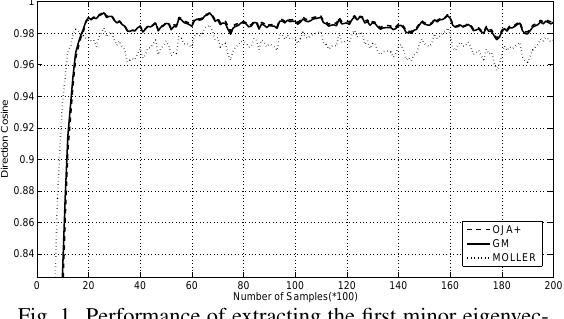
Fig. 1. Performance of extracting the first minor eigenvec- tor using algorithms GM, OJA+ and M¨ o LLER respectively.